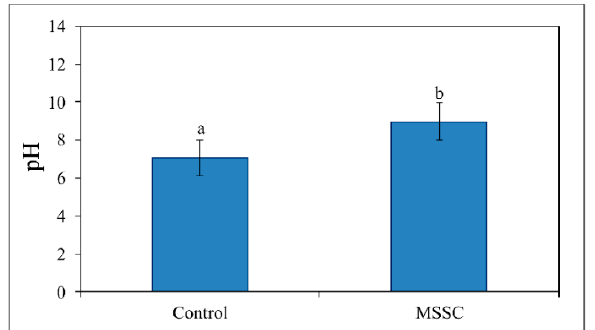
Figure 3. The pH value of the soil after the experiment. Different letters indicate significant differences in pH value of soil control soil and MSSC-amended soil.